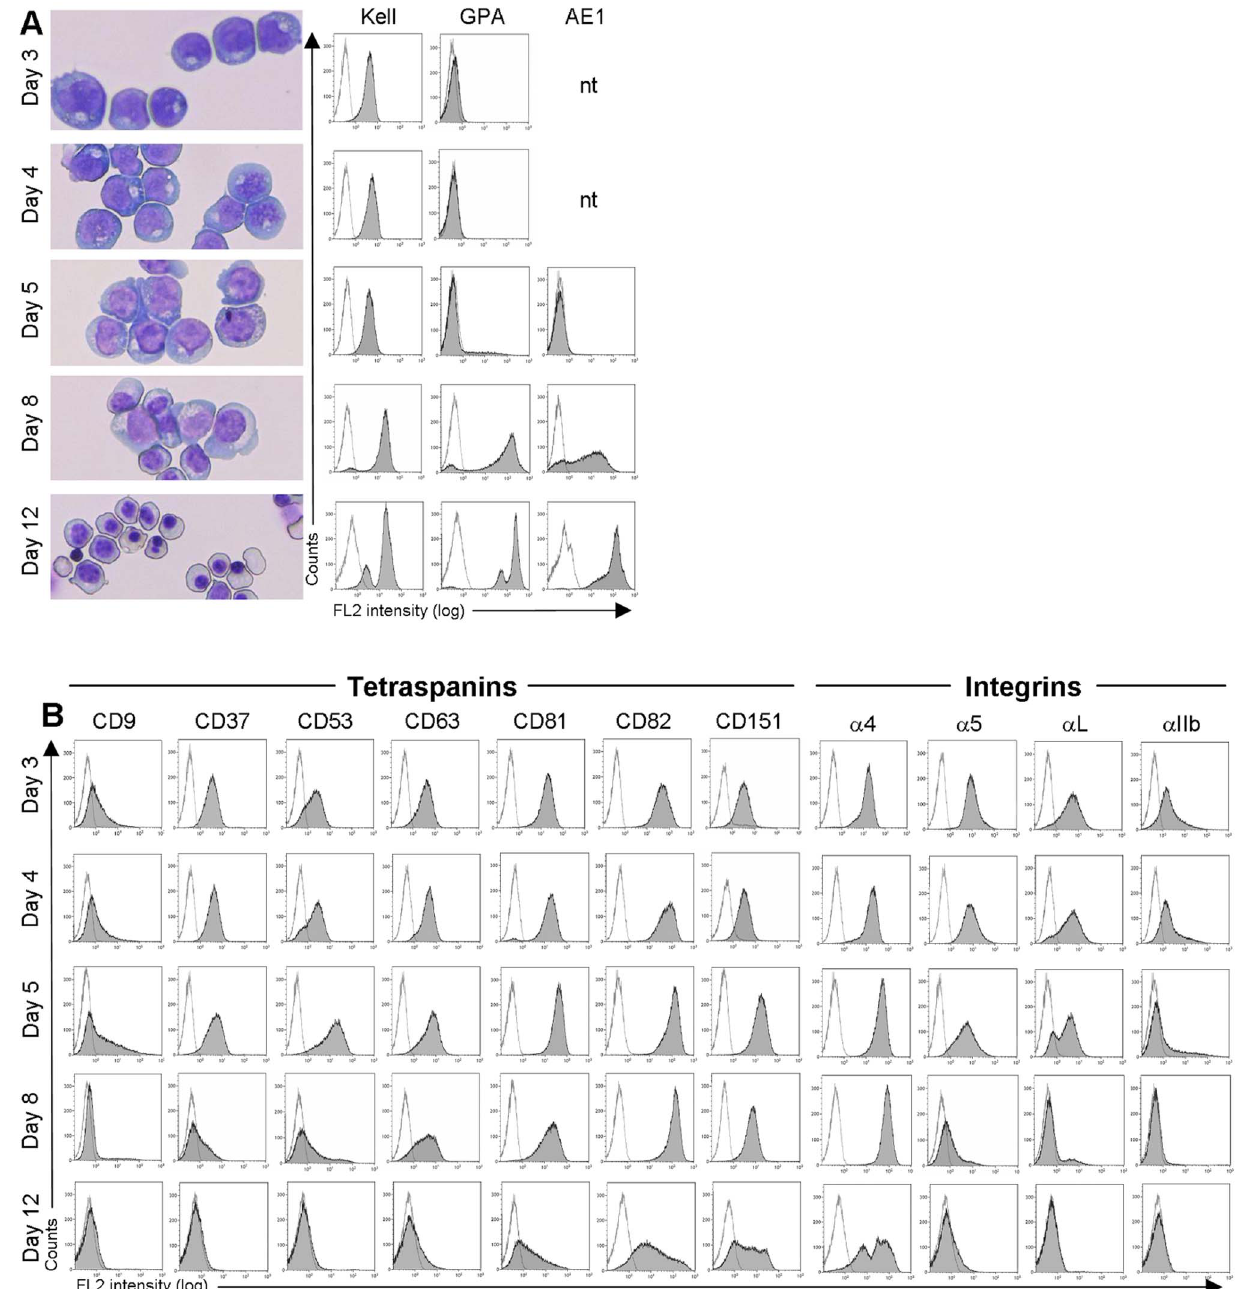
Figure 1. Erythroid culture characterisation and expression of tetraspanins and integrins during terminal maturation. A. Temporal expression of erythroid-specific markers, Kell, GPA and AE1 and morphology of the culture at the same time points. AE1 was tested from day 5 onwards. B. Tetraspanin and integrin profile of the same cultures as shown in A. Results are depicted from one culture where directly conjugated antibodies were used (days 3 and 4) and a second culture with indirectly labelled antibodies (day 5 onwards). The y-axis scale is linear to 350 counts; the x-axis is logarithmic to 10 4 . Images were captured on a Leica DM750 microscope, x20 magnification, using Image-Pro Express 6.0 software.